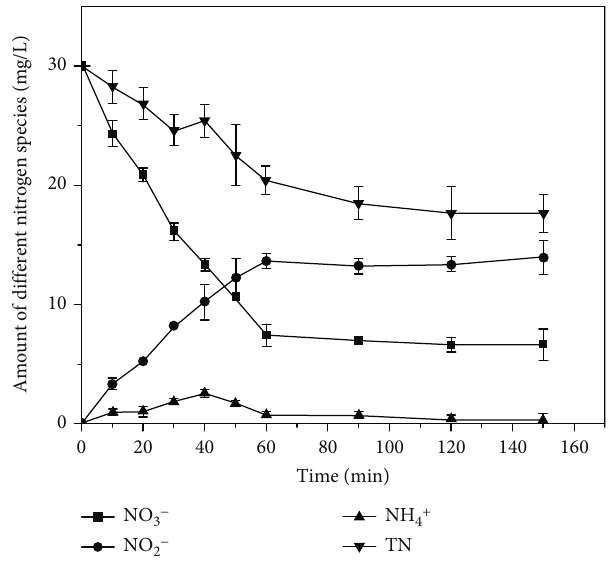
Figure 10: Change in pH during NO nZVI: nano-zero-valent iron.